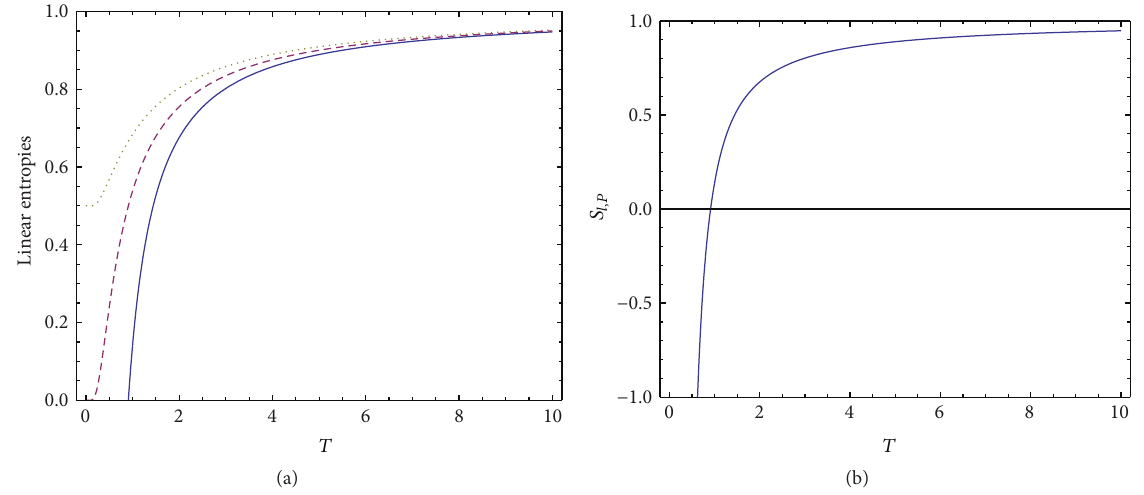
Figure 4: Left: linear entropies 𝑆 𝑙,𝑃 , 𝑆 𝑙,𝑄 , and 𝑆 𝑙,𝑊 versus the temperature 𝑇 in (ℏ𝜔/𝑘 𝐵 ) -units. The solid line is the case 𝑃 , the dashed one is the Wigner one, and the dotted curve is assigned to the Husimi instance. Right: 𝑆 𝑙,𝑃 as a function of the temperature 𝑇 in (ℏ𝜔/𝑘 𝐵 ) -units. We note that the linear entropy 𝑆 𝑙,𝑃 is negative below the 𝑇 value 𝑡